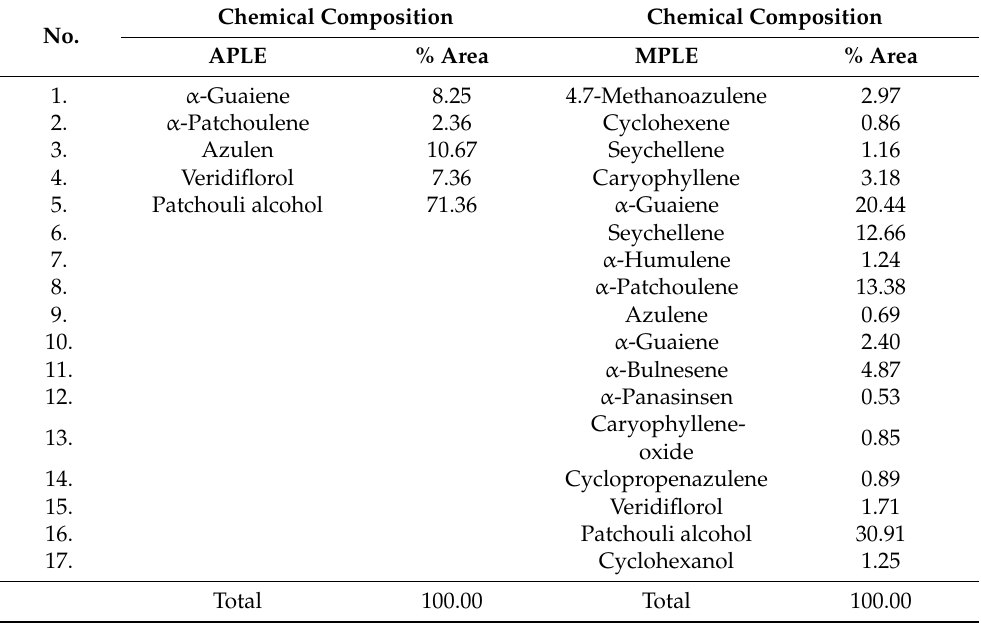
Table 3. The chemical composition of aqueous patchouli leaf extract (APLE) and methanolic patchouli leaf extract (MPLE) by GC-MS analysis.